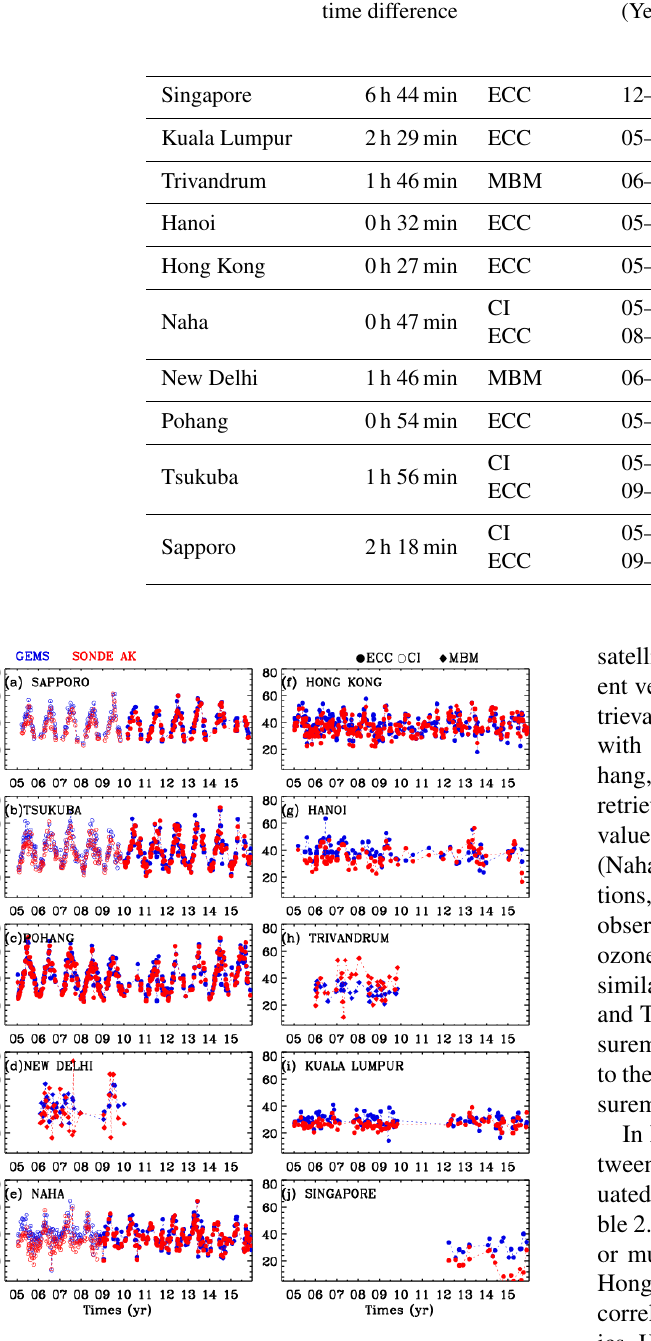
Figure 5. Time series of tropospheric ozone columns (DU) of GEMS-simulated ozone profile retrievals (blue) and ozonesonde measurements convolved with GEMS averaging kernels (red) from 2005 to 2015 at 10 stations listed in Table